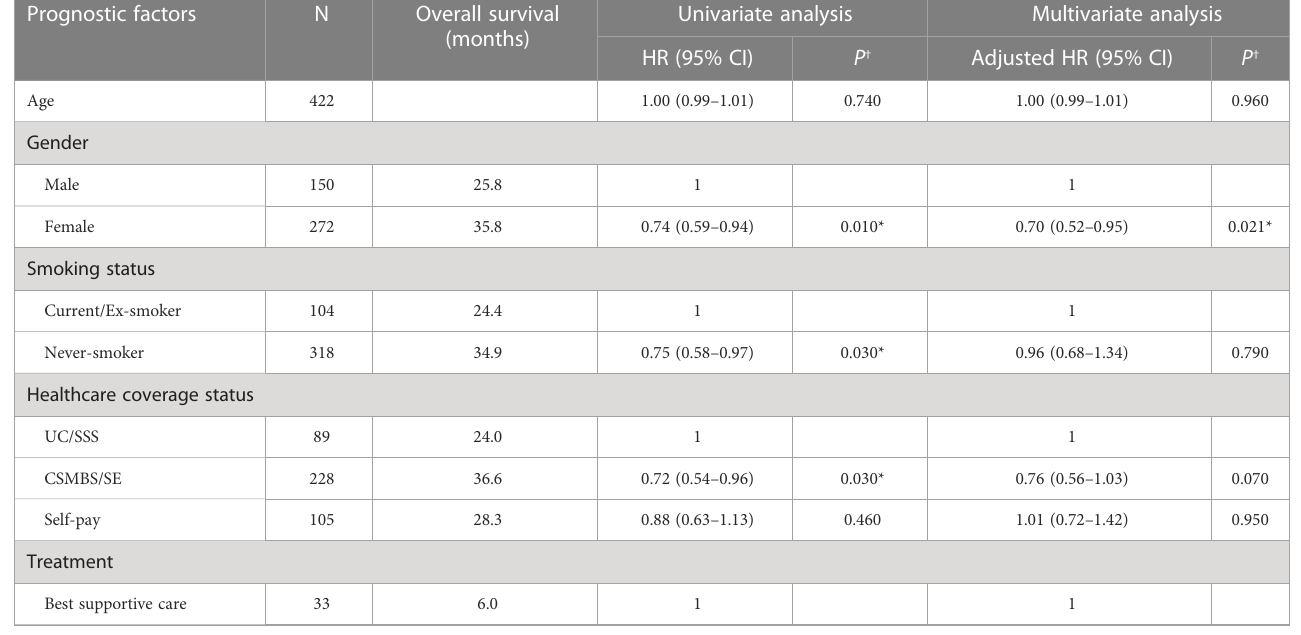
TABLE 3 Cox regression analysis of prognostic factors associated with overall survival in EGFR m-positive patients. Prognostic